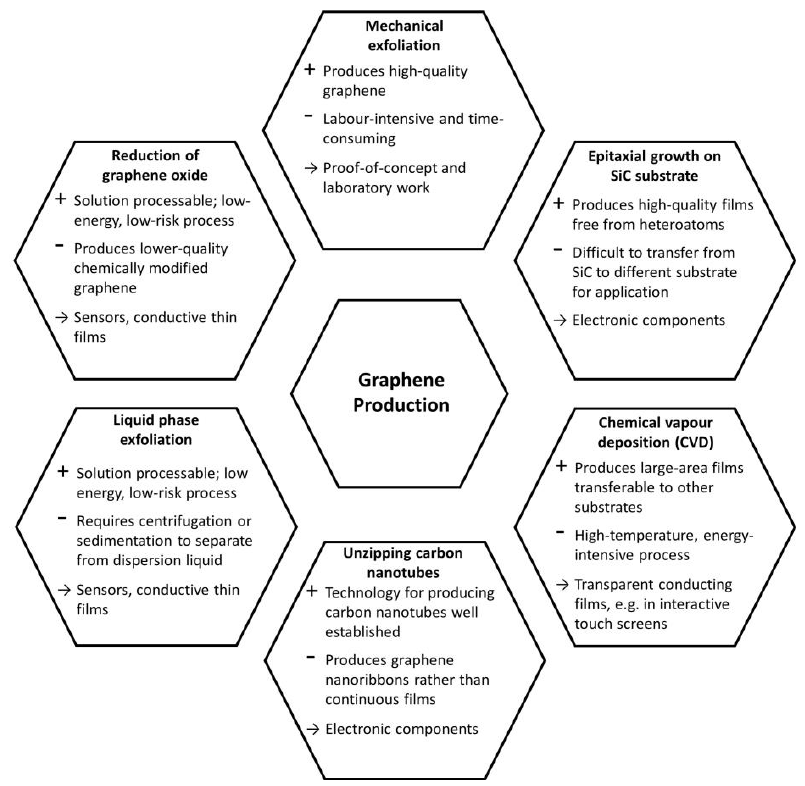
Figure 1. Summary of the main graphene synthesis methods.